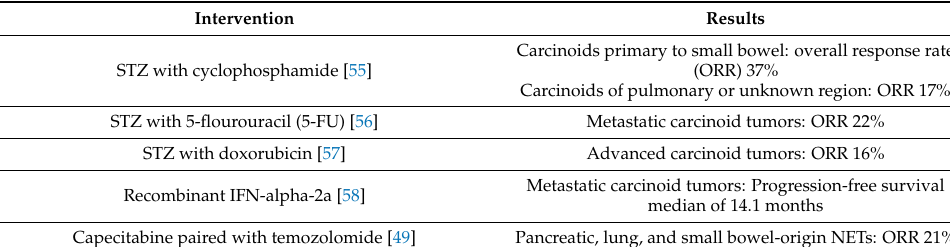
Table 2. Randomized trials of chemotherapeutics for Carcinoid Tumors.